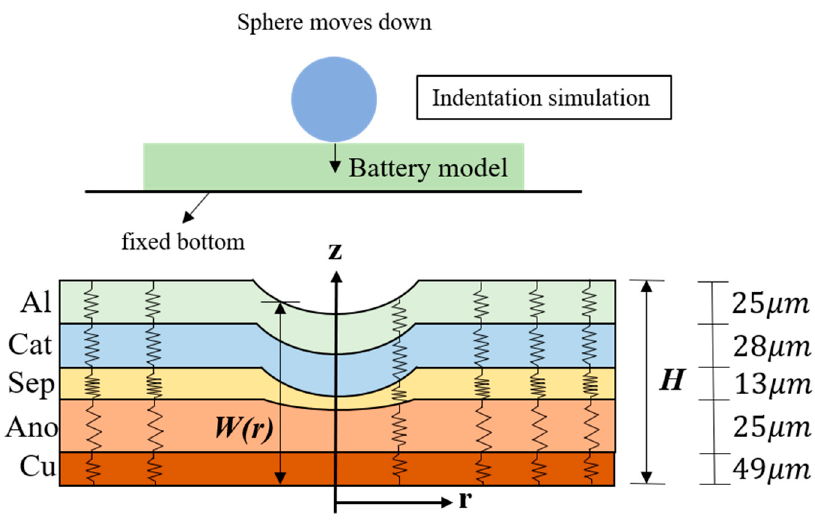
Figure 1. Schematic of the spherical indentation and a simplified one-dimensional mechanical LIB model. The thickness of each layer is taken from a former study [7].